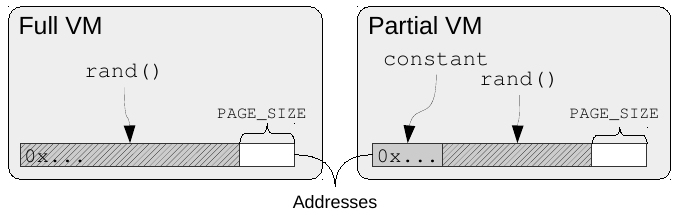
Figure 3. Full versus Partial virtual memory